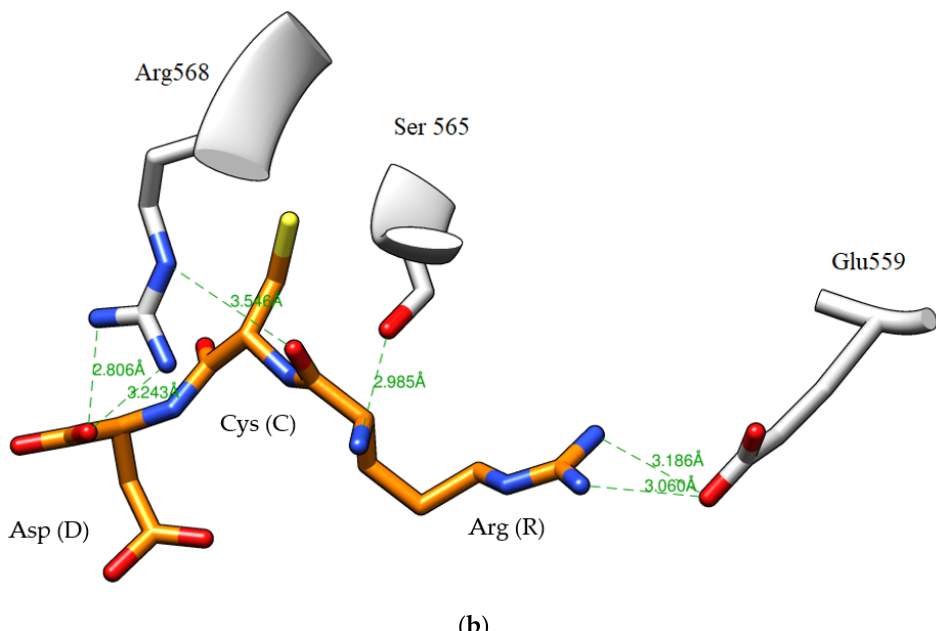
Figure A3. The interactions between tripeptides ( a ) SNV and ( b ) RCD and the HMG-CoA reductase (PDB 1HW9). The tripeptides (C, orange; N, blue; O, red; S, yellow) and the HMG-CoA reductase (C; light grey; N, blue; O, red) are colored by elements.